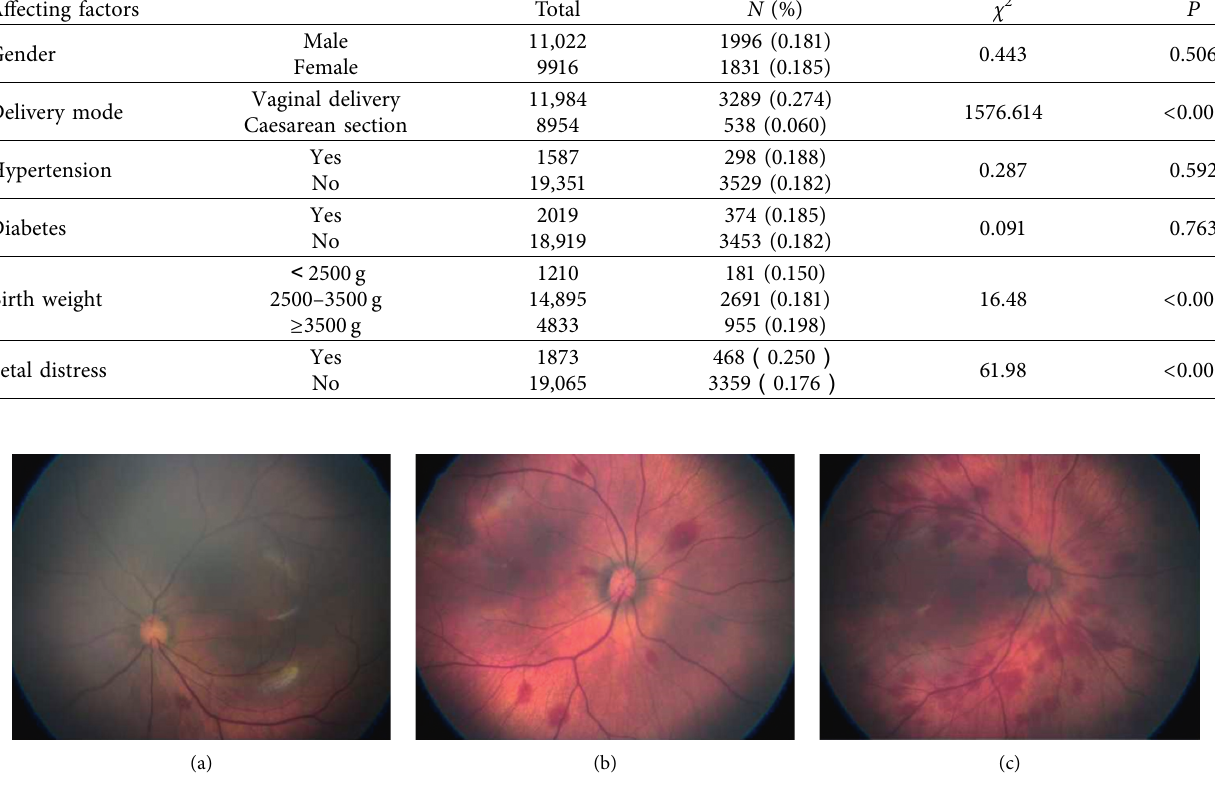
Affecting factors